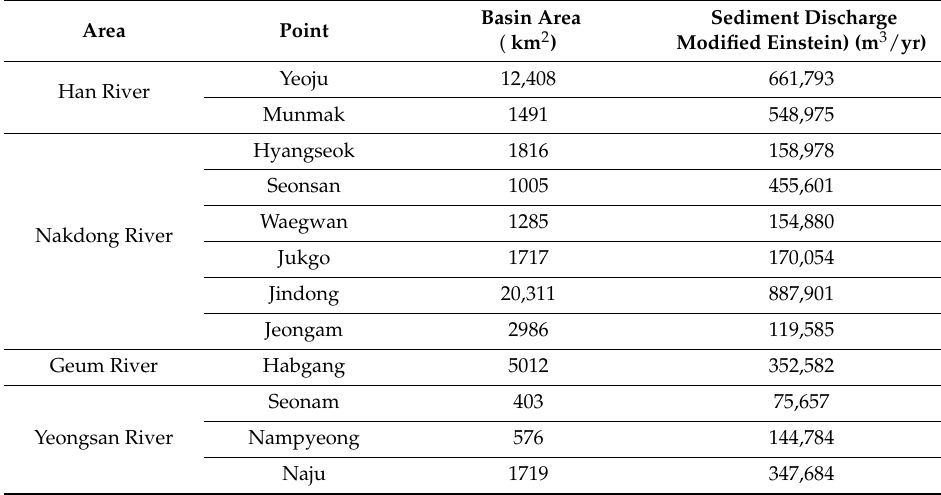
Table 3. Sediment discharge and basin area in Korea